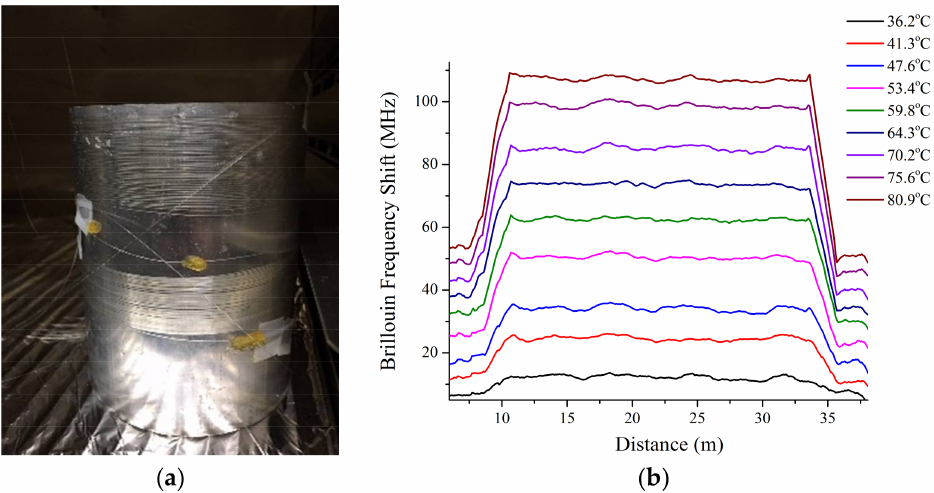
Figure 3. ( a ) Photograph of the Al cylinder with the dual-core samples wound around the cylinder; ( b ) Brillouin frequency shift of one sample at different temperatures and strains caused by the metallic cylinder